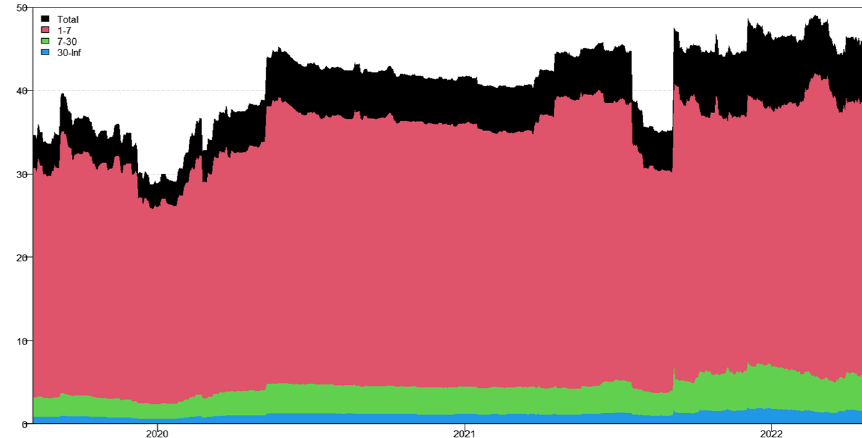
Fig. 9 Dynamic total connectedness—realized skewness (RS)